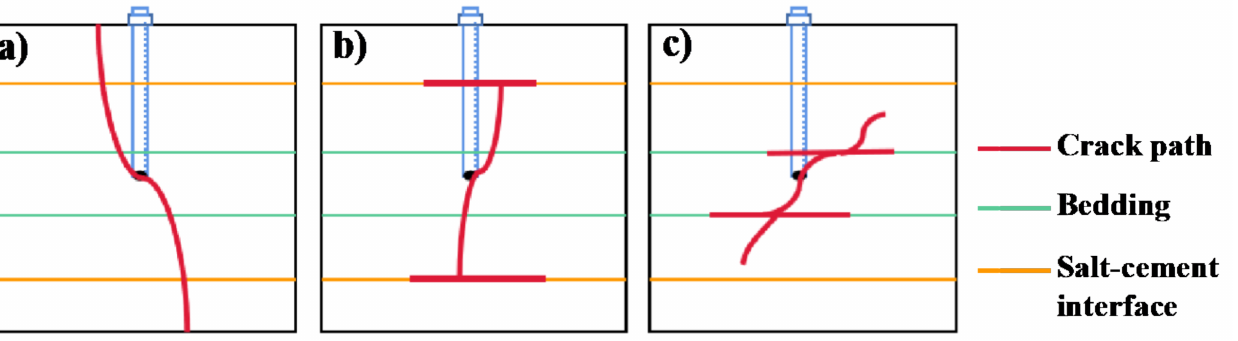
Figure 10. Basic fracture modes of specimens: ( a ) Mode I, ( b ) Mode II and ( c ) Mode